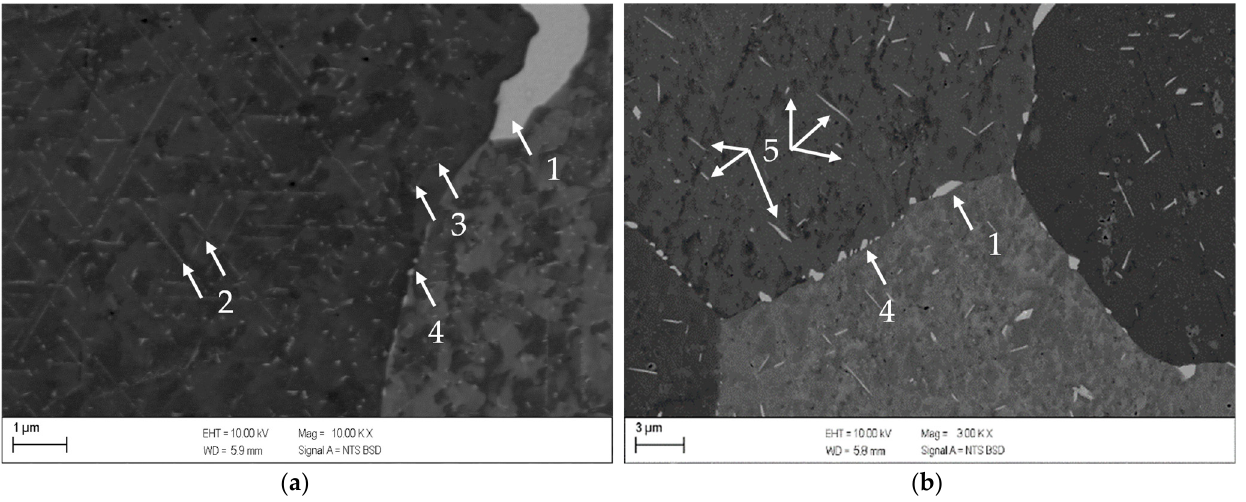
Figure 12. Precipitates of CuHf0.7 in their evolution during DSC measurements: specimen without cold rolling; ( a ) condition 1; ( b ) condition 2; showing the undissolved hafnium phase after casting (1), homogenously distributed lamellar hafnium enrichments of precipitates within a grain (2), fewer and smaller structures in the surroundings of the grain boundary (3) with hafnium migration in the intergranular space (4), and coarse precipitates due to further heating (5).